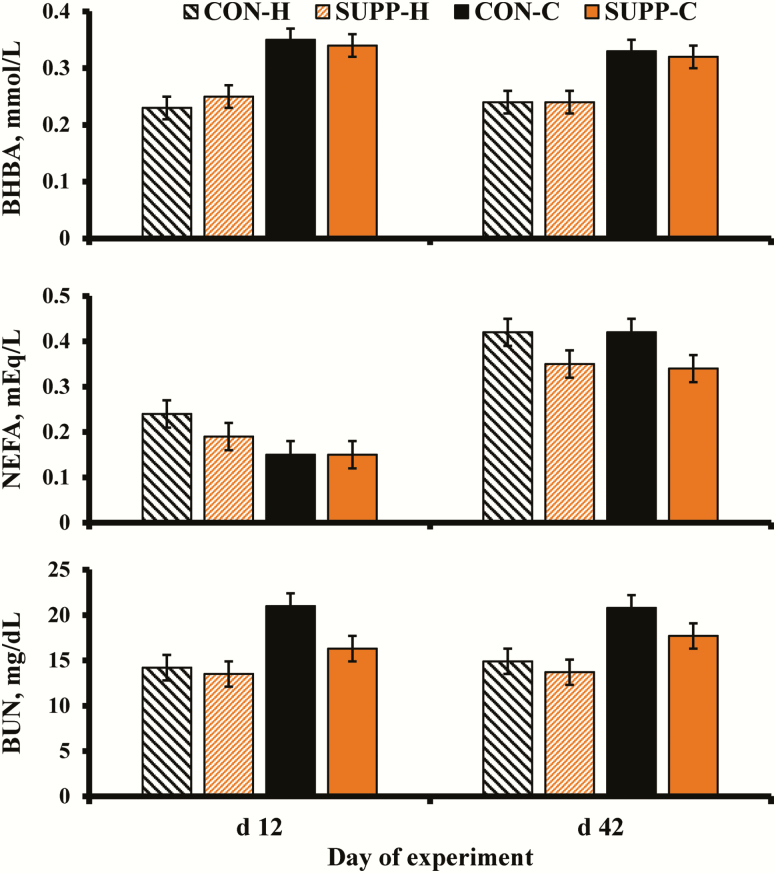
Serum concentration of NEFA, BHBA, and BUN on d 0, 12, and 42 of the four treatment combinations (n = 8 groups per treatment combination): yearling heifers receiving no supplement (CON-H); yearling heifers receiving supplement of dry-rolled corn (SUPP-H; 1.81 kg as-fed/heifer/d) for 42 d; 2-yr-old lactating cow-calf pairs receiving no supplement (CON-C); and 2-yr-old lactating cow-calf pairs receiving supplement of dry-rolled corn (SUPP-C; 1.81 kg as-fed/cow/d) for 42 d from the end of April through early June in 2017 and 2018. Supplementation × age × time, supplementation × age, supplementation × time, age × time, supplementation and time effects were not detected (P ≥ 0.22) for serum BHBA concentration; but, an age effect was detected (P < 0.01). Supplementation × age × time, supplementation × age, supplementation × time, age × time and age effects were not detected (P ≥ 0.11) for serum NEFA concentration; however, supplementation and time effects were detected (P ≤ 0.02). Supplementation × age × time, supplementation × age, supplementation × time, age × time and time effects were not detected (P ≥ 0.18) for serum BUN concentration; but, supplementation and age effects were detected (P ≤ 0.03). Error bars = SEM.